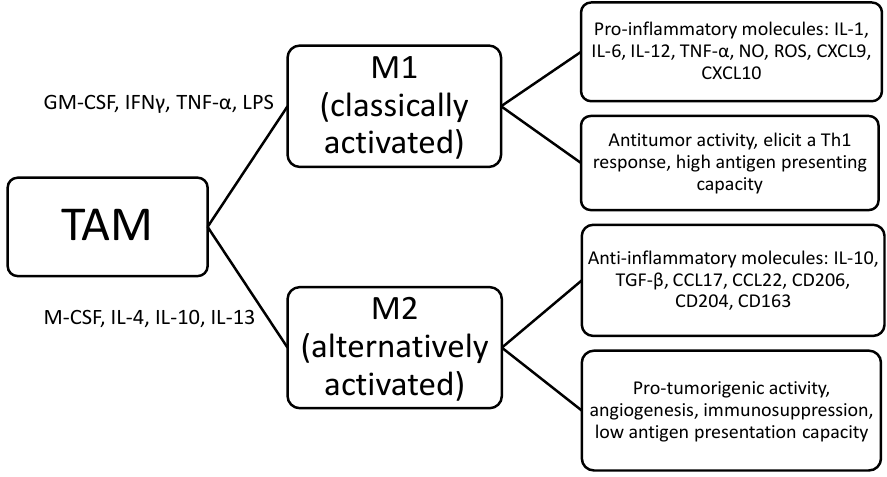
Figure 1. Tumor-associated macrophages polarization model in hematologic malignancies. TAM, tumor-associated macrophages; GM-CSF, granulocyte and monocyte colony stimulating factor; IFN, interferon; TNF, tumor necrosis factor; LPS, lipopolysaccharide; M-CSF, monocyte colony stimulating factor; IL, interleukin; TNF, tumor necrosis factor; NO, nitric oxide; ROS, reactive oxygen species; CXCL, chemokine ligands with C-X3-C motif; Th, T helper; TGF, tumor growth factor.